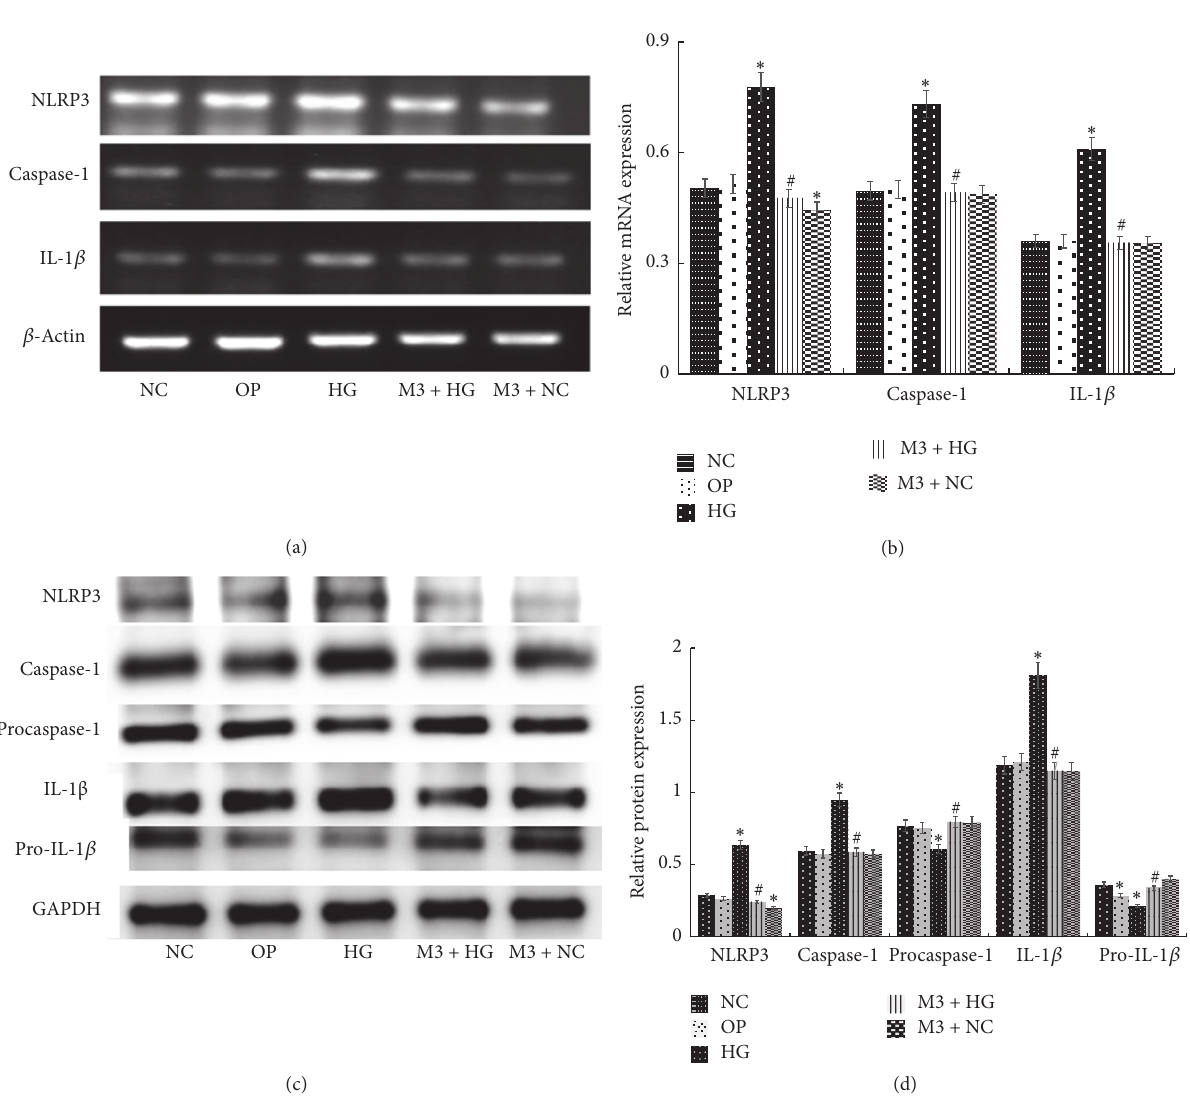
Figure 4: The level of NLRP3, caspase-1, P-caspase-1, IL-1 𝛽 , and P-IL-1 𝛽 in each group. (a) RT-PCR detected the expression NLRP3, caspase-1, and IL-1 𝛽 mRNA after intervened by high glucose and 100nmol/L maresin 1 in GMCs, and in HG group, the mRNA expression of NLRP3, caspase-1, and IL-1 𝛽 was higher than that in NC group, but for M3 + HG group, the expression reduced visibly compared to the HG group. (b) The corresponding relative gray value statistics graph of the mRNA level. ∗ 𝑃 < 0.05 versus NC group, # 𝑃 < 0.05 versus HG group. (c) Western-blot detected the expression of NLRP3, caspase-1, P-caspase-1, IL-1 𝛽 , and P-IL-1 𝛽 protein after intervened by high glucose and 100nmol/L maresin 1 in GMCs, and the protein expression of NLRP3, caspase-1, and IL-1 𝛽 was higher than that in NC group, but for M3 + HG group, the expression reduced visibly compared to the HG group. The expression of P-caspase-1 and P-IL-1 𝛽 was just the reverse. (d) The corresponding relative gray value statistics graph of the protein level. ∗ 𝑃 < 0.05 versus NC group, # 𝑃 < 0.05 versus HG